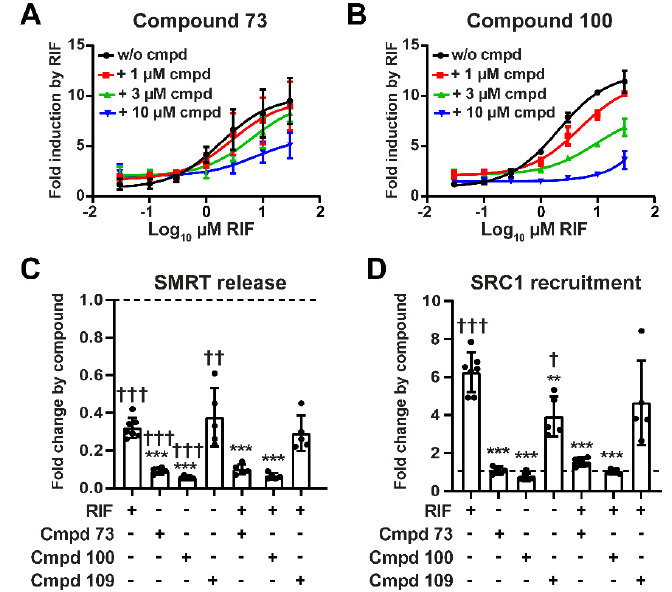
Figure 3. Compounds 73 and 100 act as mixed competitive/noncompetitive passive antagonists of PXR. ( A , B ) Effects of novel PXR antagonists on the concentration–response curve of rifampicin. H-P cells were transfected with CYP3A4 promoter reporter and cotreated with increasing concentrations of rifampicin (RIF) with or without fixed concentrations of 73 and 100 . Effects of novel compounds on PXR`s interactions with corepressor SMRT ( C ) and coactivator SRC1 ( D ). HepG2 cells were cotransfected with GL4-G5 reporter gene and expression plasmids encoding VP16-PXR LBD(108–434) and ( C ) GAL4-DBD-SMRT-RID or ( D ) GAL4-DBD-SRC1-RID fusion proteins and treated with 0.2% DMSO, 10 µ M test compounds alone, or cotreated with 10 µ M rifampicin. Data are shown as